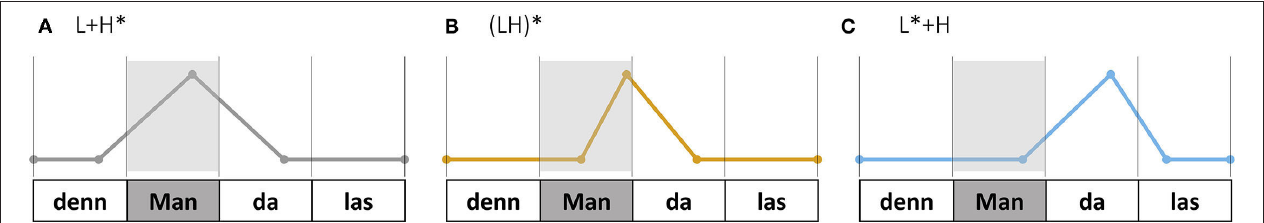
FIGURE 1 | Schematic representation of three rising-falling contours in German realized on a four-syllable sequence denn Mandalas “PRT Mandalas;” gray shading indicates the stressed syllable (tonic syllable) with which the pitch accent is associated. (A–C) show the three different alignment configurations analyzed in the present